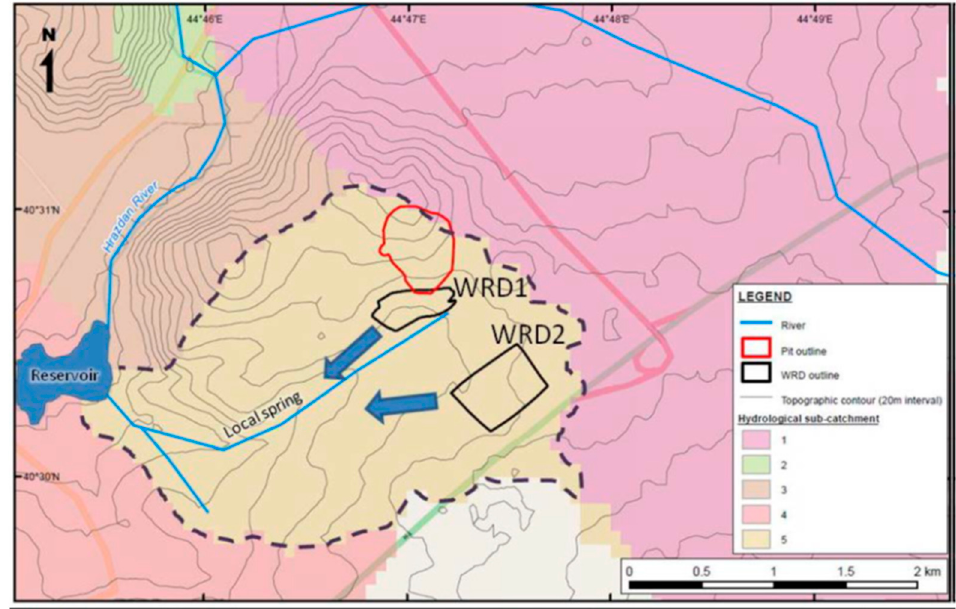
Figure 3. Simplified illustration of the mine plan for Hrazdan showing the pit outline and the two-waste rock (WRD) dump outlines. The waste facilities are situated within the same hydrological sub-catchment which would drain towards the reservoir. Dashed line shows mining area.